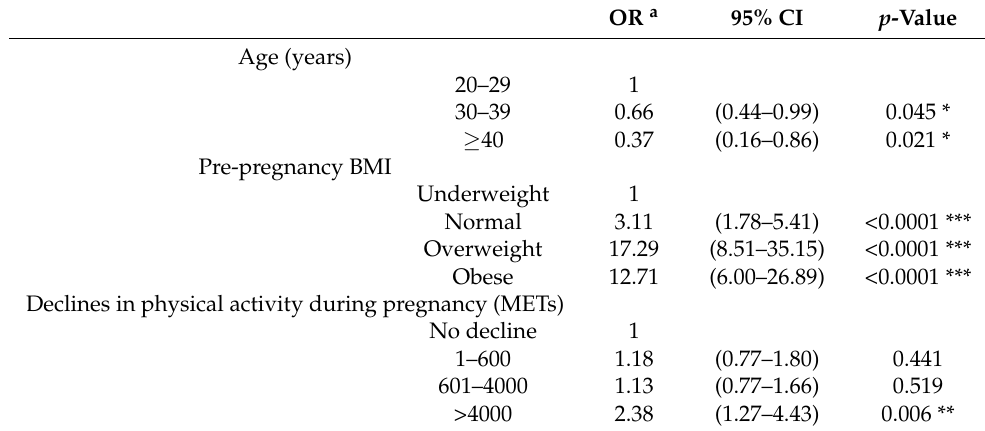
Table 4. Logistic Regression Model for Factors Associated with Excessive Gestational Weight Gain ( n =